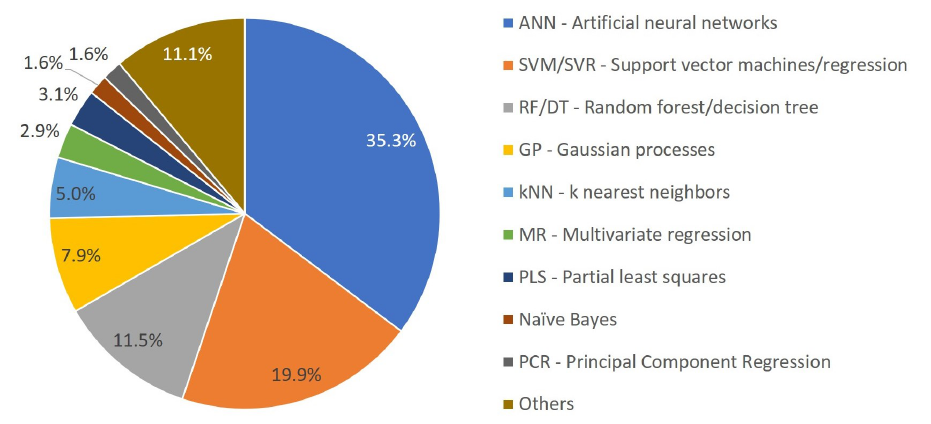
Figure 2. Distribution of the different ML categories in the reviewed CPE applications.